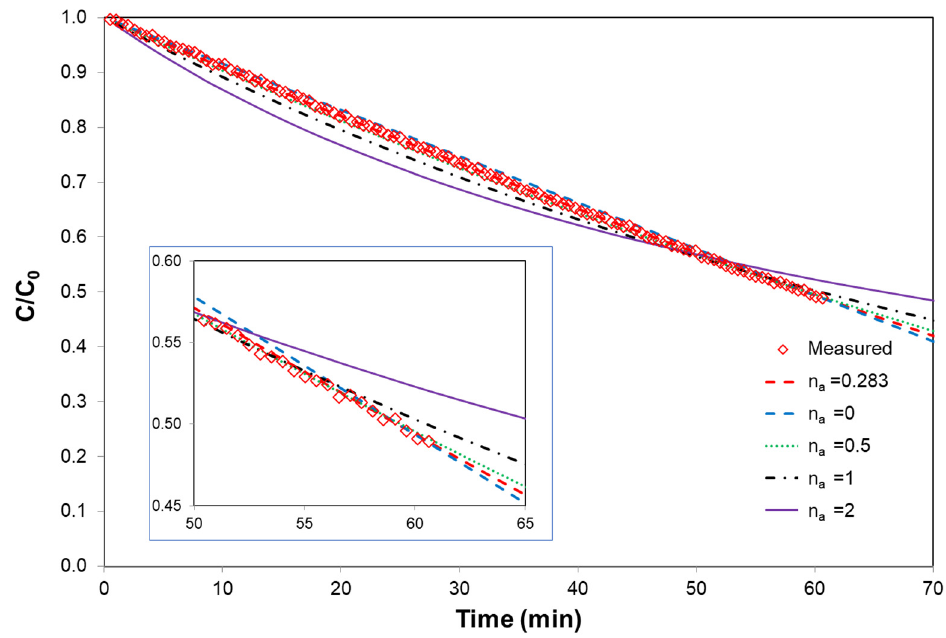
Figure 1. Photolysis of 20 µ M ofloxacin. Red squares represent measured values, whereas lines represent different calculated amounts using Equations (2) and (3) and optimized kinetic coefficient parameters (see Table 1). Inset emphasizes fits and differences close to t = 59.2 min.